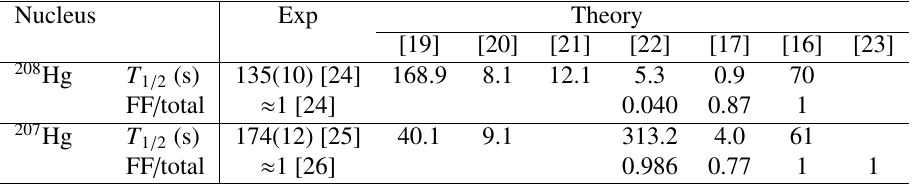
Table 1. Experimentally determined halflives and first-forbidden beta decay contribution for the β decays of 208 Hg and 207 Hg, compared with theoretical